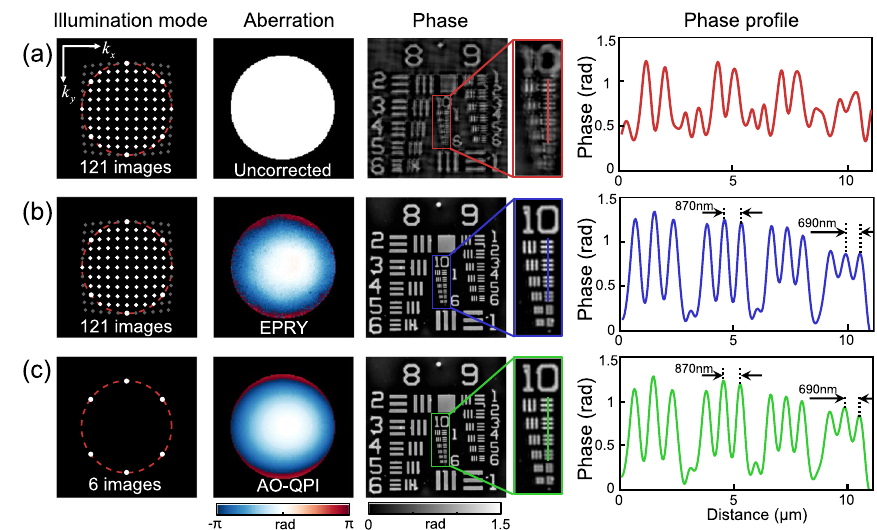
Fig. 3 The experimental results on a quantitative phase microscopy target. (a) The reconstructed results with full 121 images with the aberration correction, including the illumination mode of the LED array (the red circle is NA of the objective lens), recovered aberration, recovered phase and corresponding phase profile. (b) The reconstructed results with full 121 images using the EPRY method. (c) The reconstructed results with 6 images using the AO-QPI